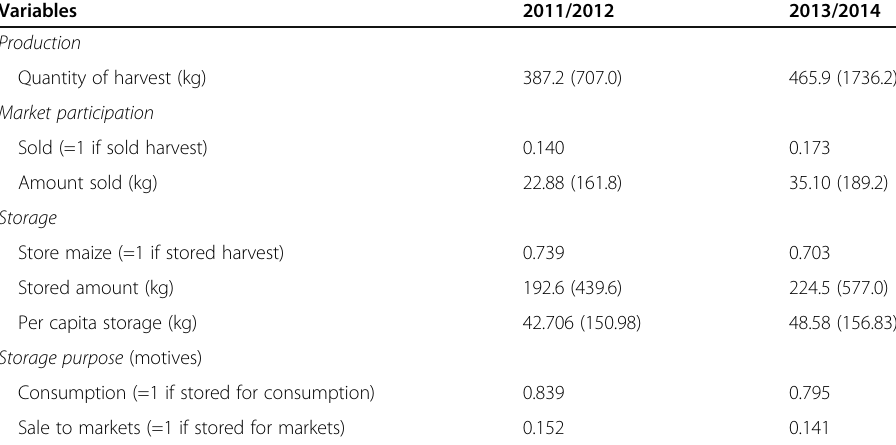
Table 2 Maize production, market participation, and